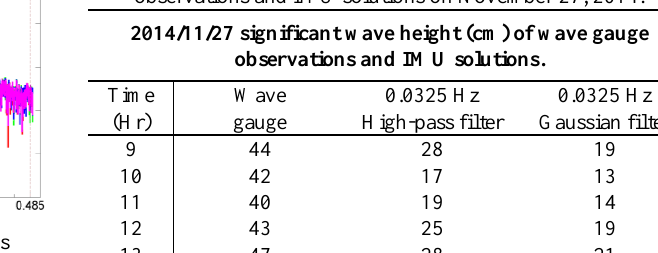
Table 3. Significant wave height of Anping wave